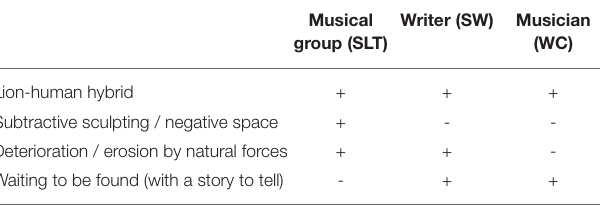
TABLE 2 | Presence (+) or absence (-) of through-line in the work of the creators.